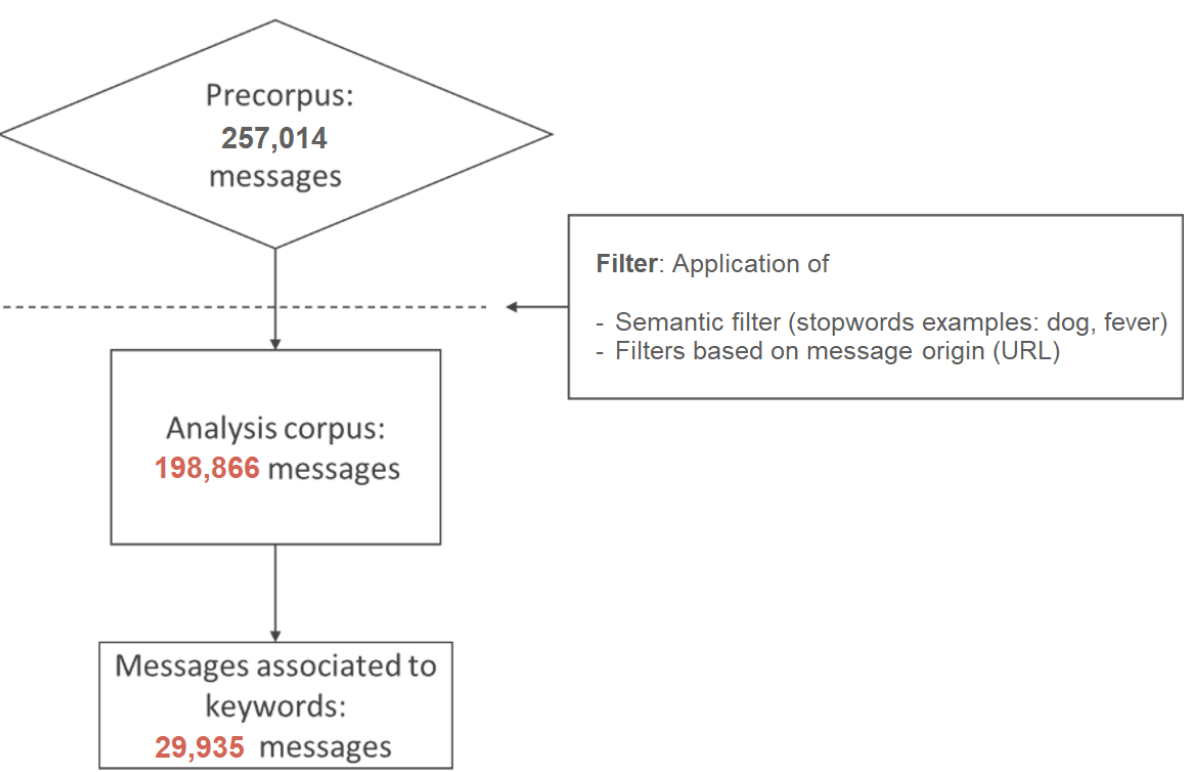
Figure 2. Flowchart presenting message